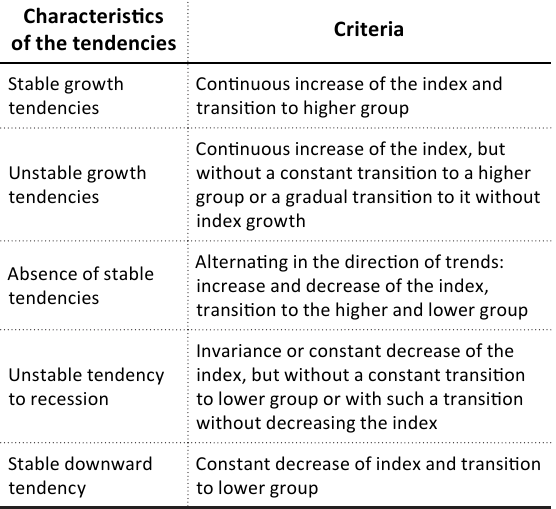
Table 2. Criteria for determining the trend of changing the efficiency of the water resources management system at the territorial